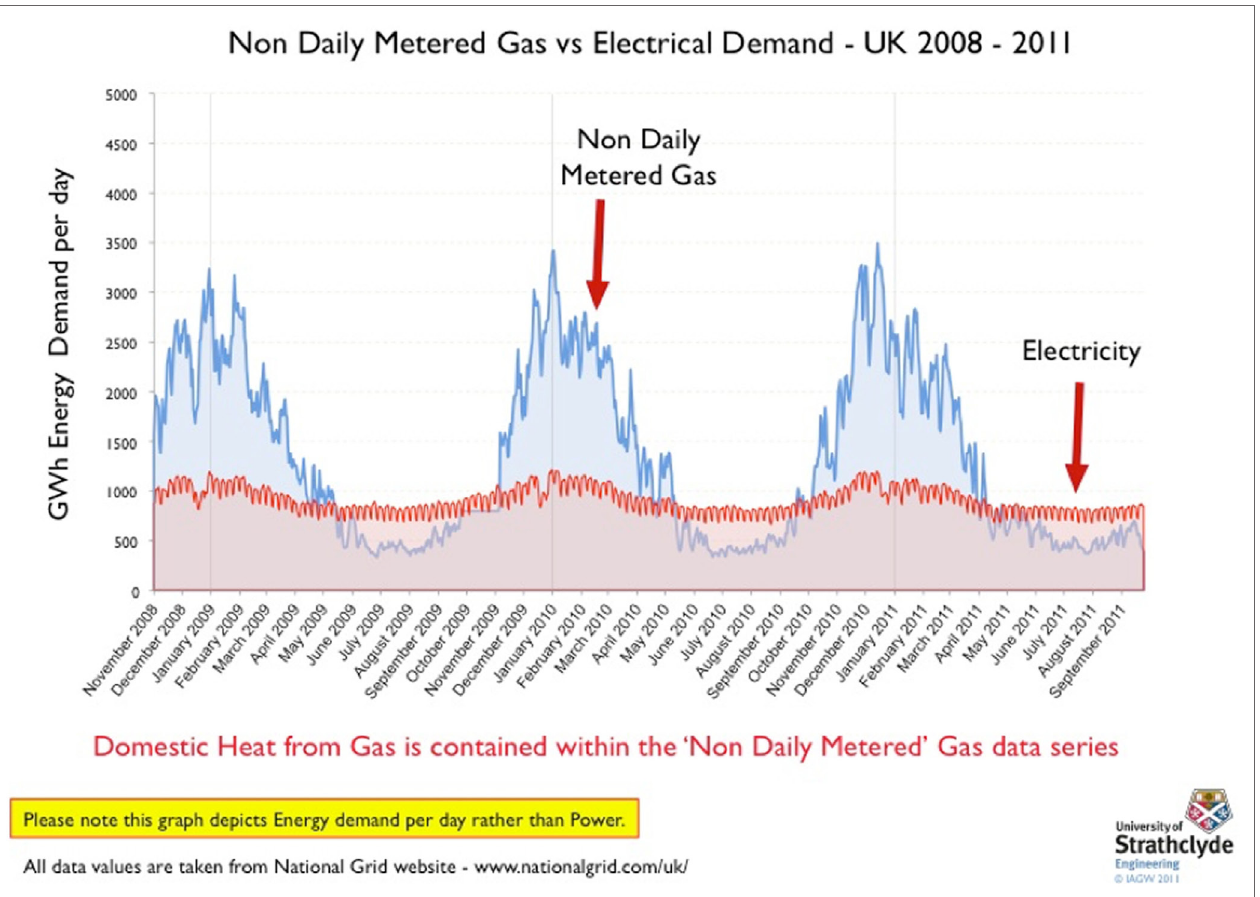
FiGUre 2 | the initial saed from a presentation in March 2012